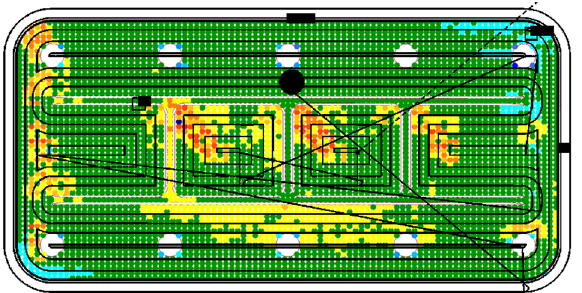
Figure 32. Tool path overlaid on CMM result, showing correlation between areas of large error with sudden change in toolpath direction.